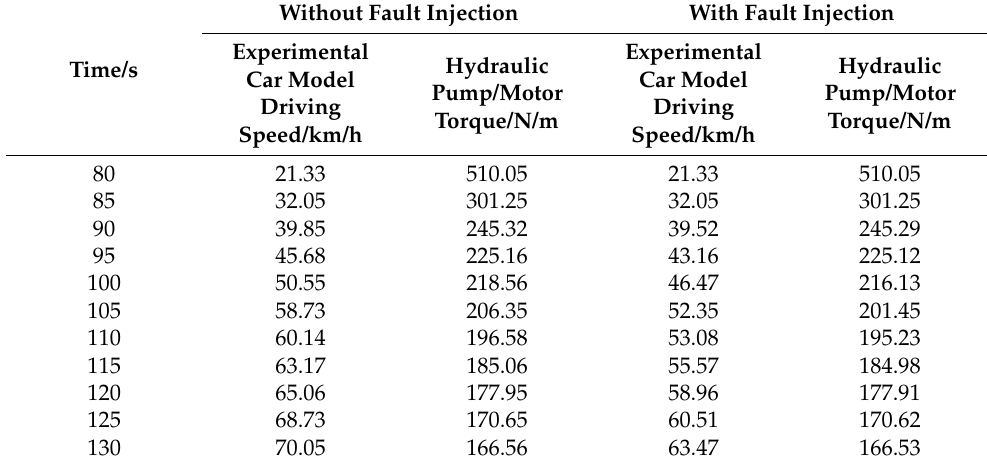
Table 4. Variation in the driving speed and hydraulic pump/motor torque of experimental vehicle models with and without